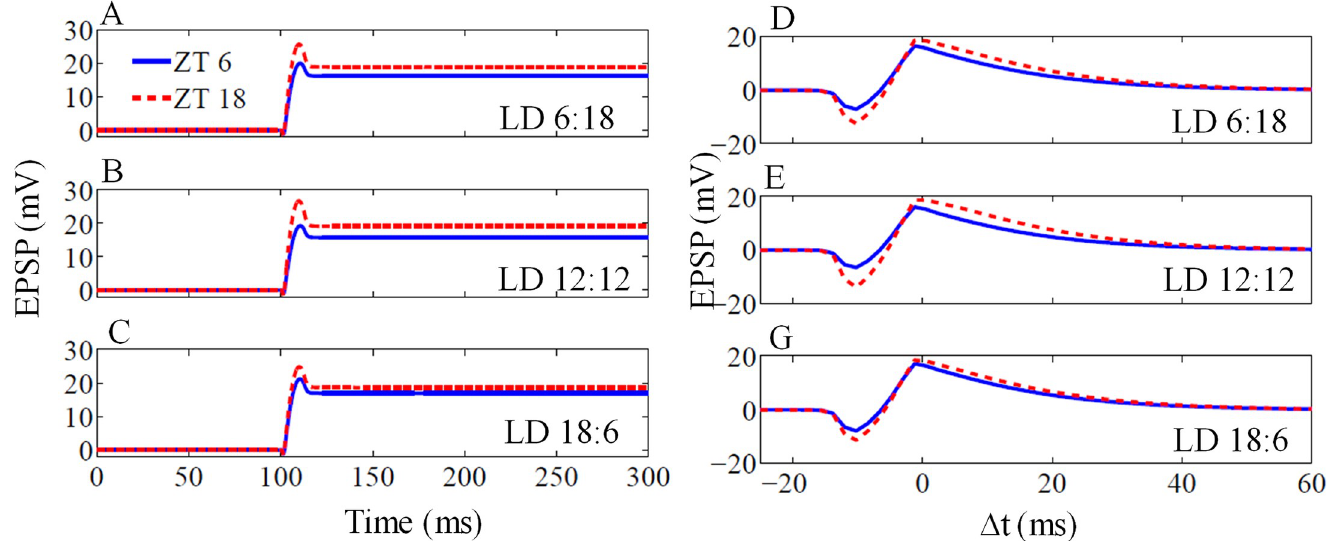
Fig 8. LTP and STDP under different LD cycles. (A-C) LTP for ZT6 (blue line) and ZT18 (red broken line) under different LD cycle with Δ t = 0. For all LD case, LTP during subjective night (ZT18) is higher than subjective day (ZT6). (D-E) STDP curves obtained at ZT6 and ZT18 under different photoperiods. For all the LD case, the magnitude of EPSP amplitude during subjective night is higher than the subjective day.